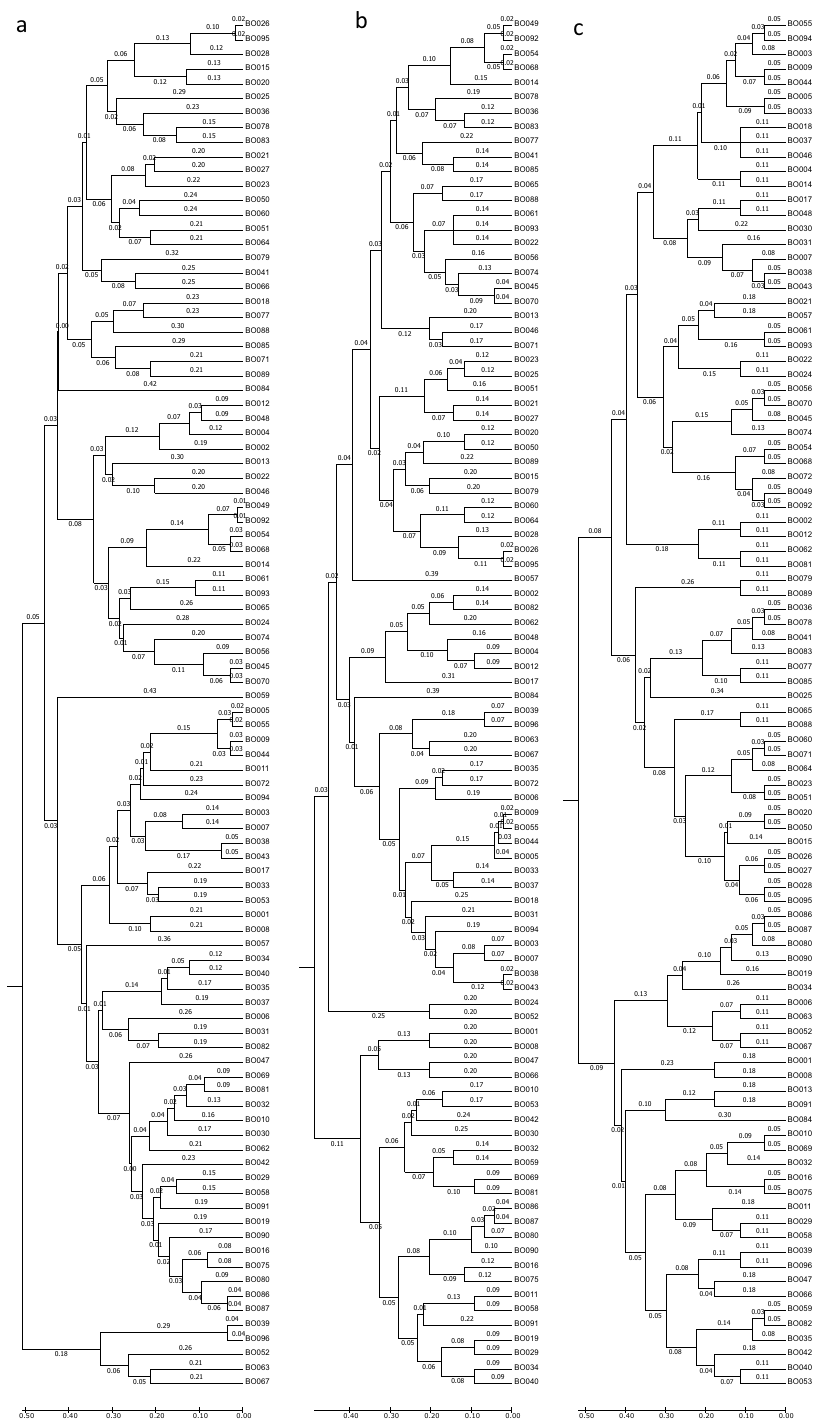
Figure 2. Phylogenetic trees based on Fluidigm genotyping results using core single nucleotide polymorphism (SNP) markers in 94 cabbage varieties. To determine the genetic relationship of cabbage varieties, a total of 94 varieties were genotyped with 87, 24, and 10 core SNP markers. The optimal tree with the sum of branch length is 20.9, 18.6, and 16.5